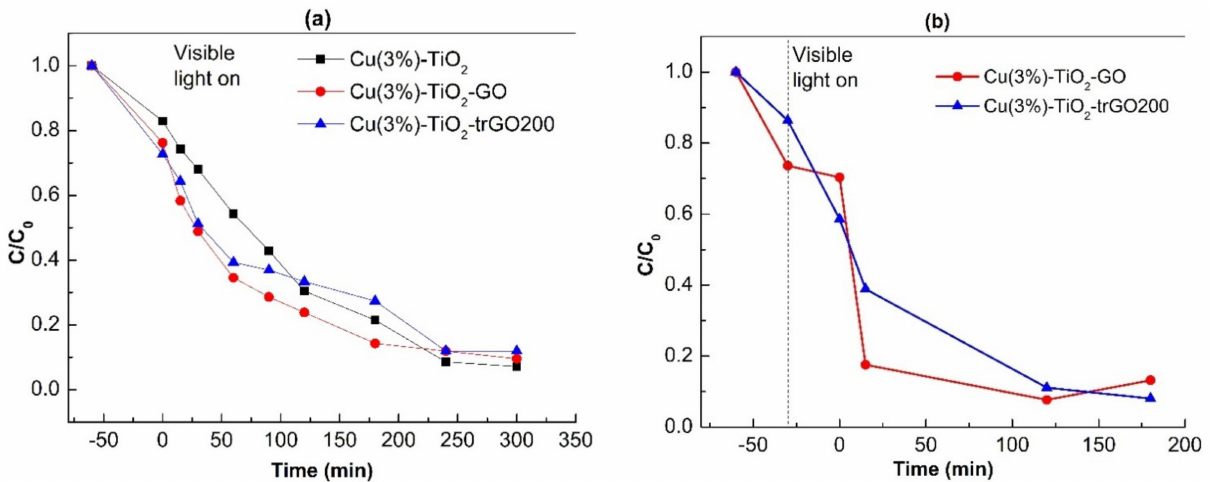
Figure 7. Residual ratio of ( a ) AMX (starting 1 mg/L) at a 0.5 mg/mL catalyst loading; ( b ) CPX (start- ing 2 mg/L) at a 0.2 mg/mL catalyst loading during adsorption/visible light degradation